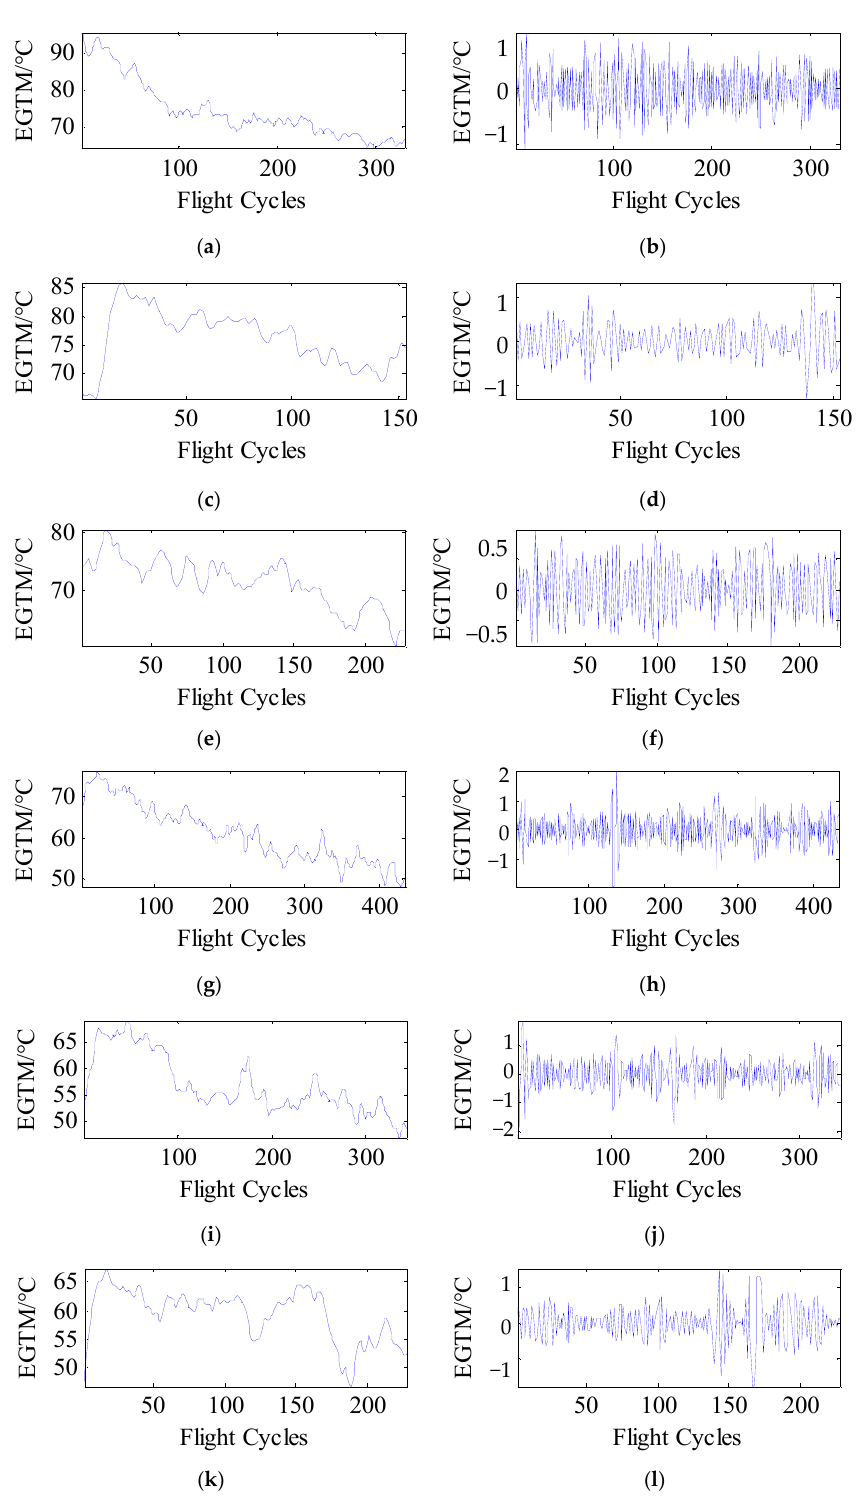
Figure 10. Components of the six-segment aeroengine training data. ( a ) No. 1 data residual component; ( b ) No. 1 data IMF component; ( c ) No. 2 data residual component; ( d ) No. 2 data IMF component; ( e ) No. 3 data residual component; ( f ) No. 3 data IMF component; ( g ) No. 4 data residual component; ( h ) No. 4 data IMF component; ( i ) No. 5 data residual component; ( j ) No. 5 data IMF